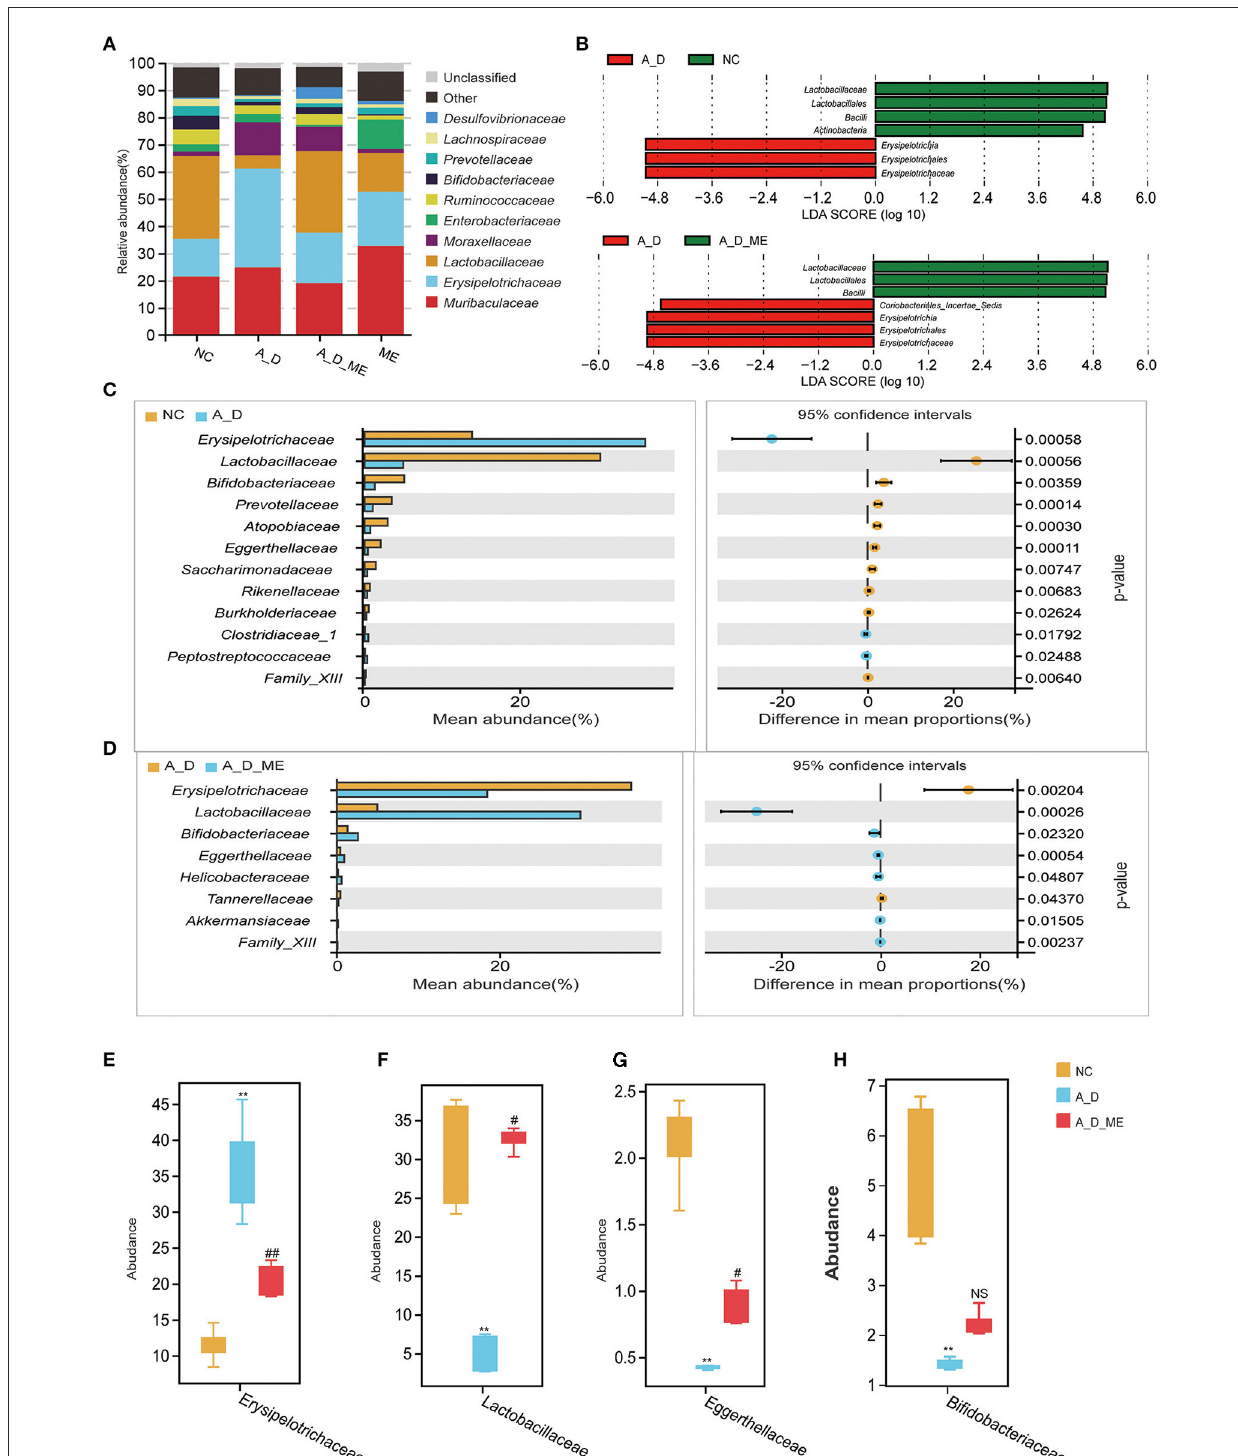
FIGURE6 Effects of ME intragastric administration on the proportion of intestinal microbiota at the family level. (A) Each column in the histogram shows the relative abundance for one group and detailing the top 10 species among the mean abundance of each sample. The remaining unknown species and unclassified sequencing data were separately marked as “Other” and “Unclassified”. (B) differences in biomarkers by means of taxonomic line discriminant analysis (LDA) effect size (LEfSe) method among the NC, A_D, A_D_ME groups. LDA scores indicated by the bar graph represent the effect of the different species at the family level. (C, D) differences of abundance at the family level in the NC group compared with the A_D group (C) and the A_D group compared with the A_D_ME group (D) , Welch’s t-test is used to identify the difference between the two groups. Differentially abundant family according to ME administration. (E–H) Box plots are shown by mean data (SD) of the abundance ratio of four families ( Erysipelotrichaceae, Lactobacillaceae, Eggerthellaceae, and Bifidobacteriaceae among five individuals in every three groups. Tukey’s HSD test is used to analyze the differences. N = 5/group, * p < 0.05, vs. NC, ** p < 0.01, vs. NC; # p < 0.05, vs. A_D, ## p < 0.01, vs. A_D, ns means no